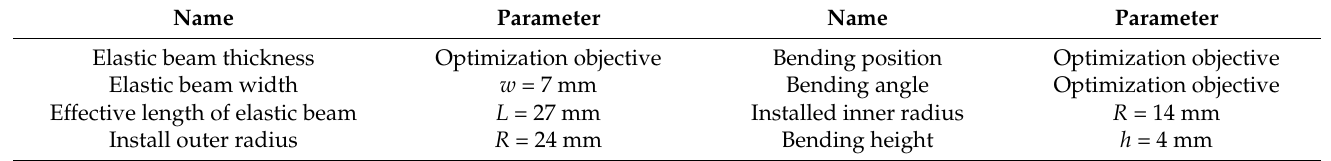
Table 1. Structural parameters of beryllium bronze reed.